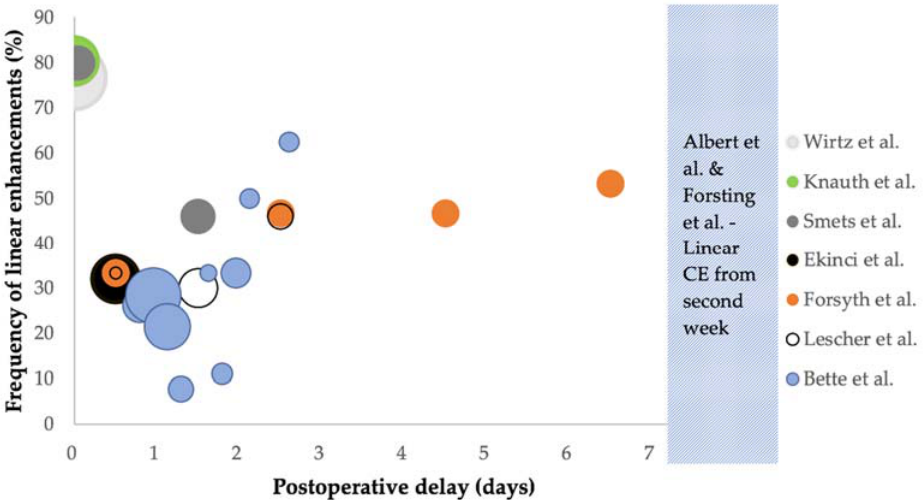
Figure 2. Bubble chart showing the total frequency of linear enhancements ( y -axis) at different time intervals during or after surgery ( x -axis), with the median of each reported time interval registered on the x -axis. The size of the bubble represents the total number of patients who had MRI performed, up to 86 patients for Wirtz et al. [29]. Each study is presented with a different colour as shown in the legend. Plots for Ekinci et al. [15], Lescher et al. [16] and Forsyth et al. [31] were calculated by the authors of this review using data from each paper. All grades of linear enhancement are shown for Forsyth et al. Abbreviations: CE, contrast enhancement.